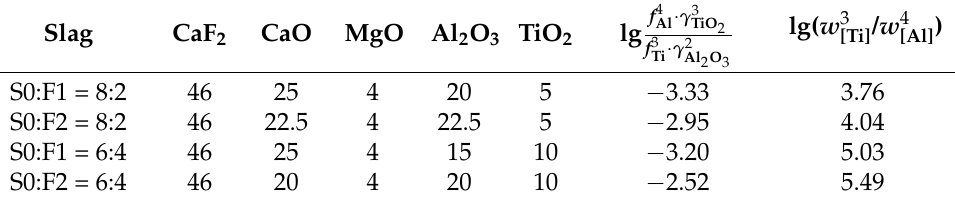
) and slag listed in Table 2 determined by experiments. / w 4 [ Al ] [ Ti ]